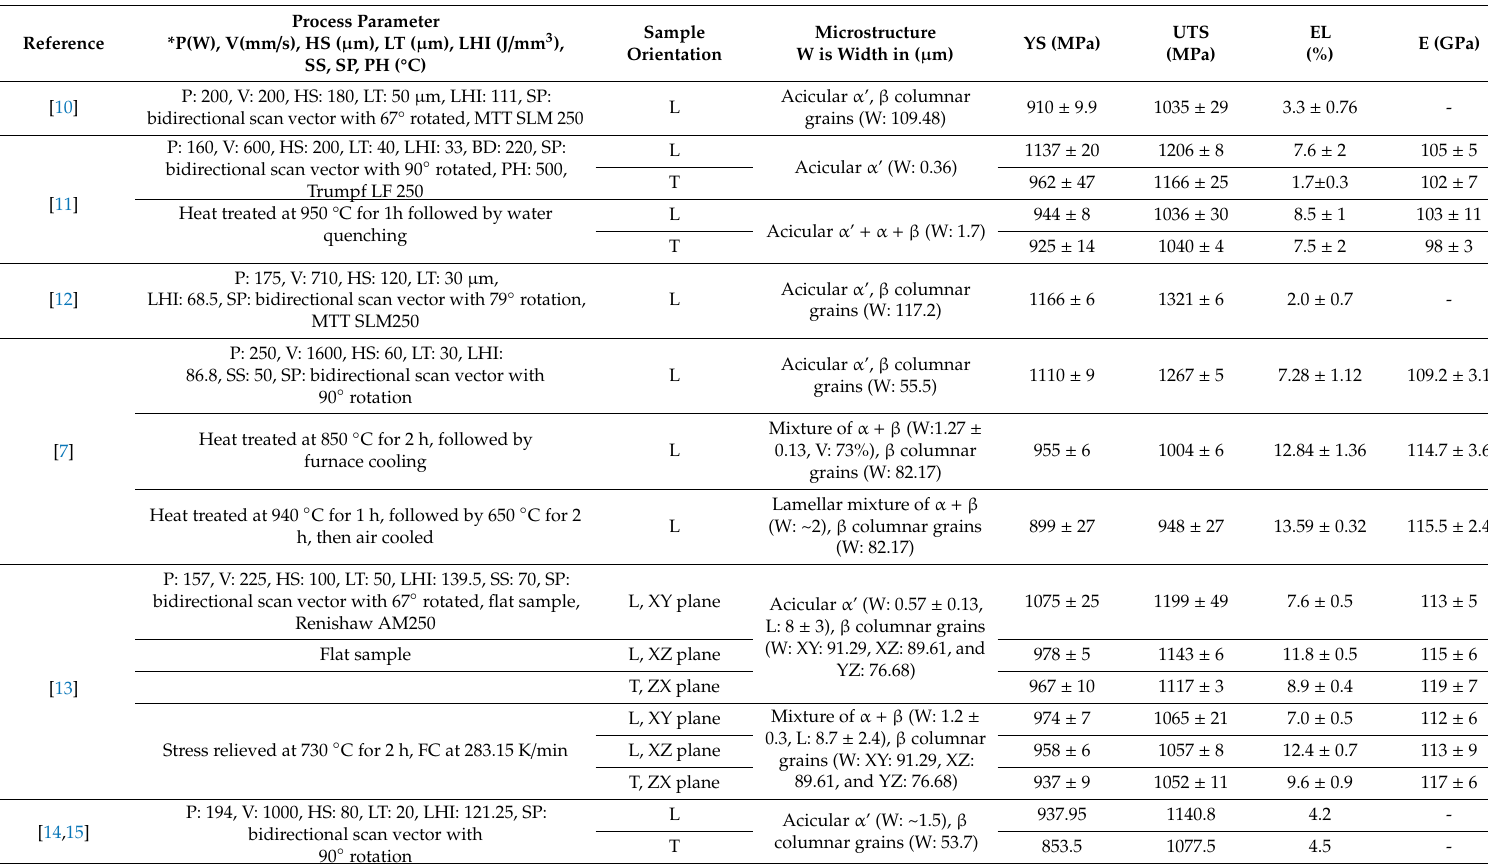
Table 1. List of microstructures ( α lath and prior β columnar width) and corresponding mechanical property from literature. The mechanical data are included from the work which reported mechanical property along with their microstructure